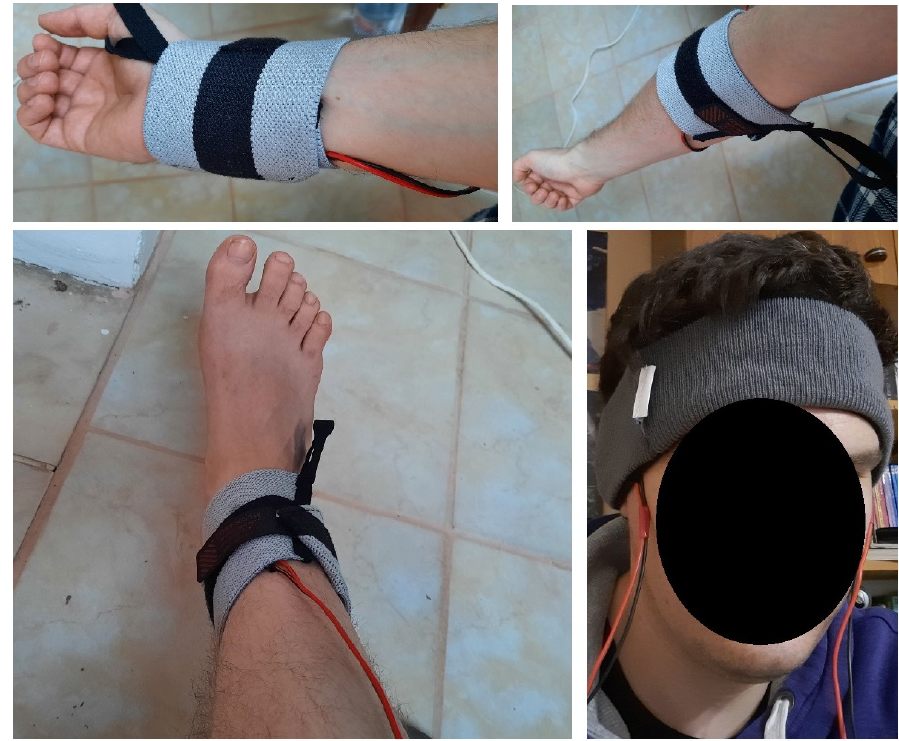
Figure 5. Fixing points on the human